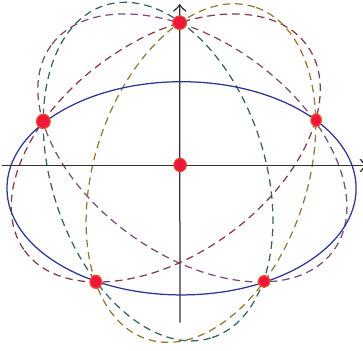
F 3: Six data points and �ve �tting